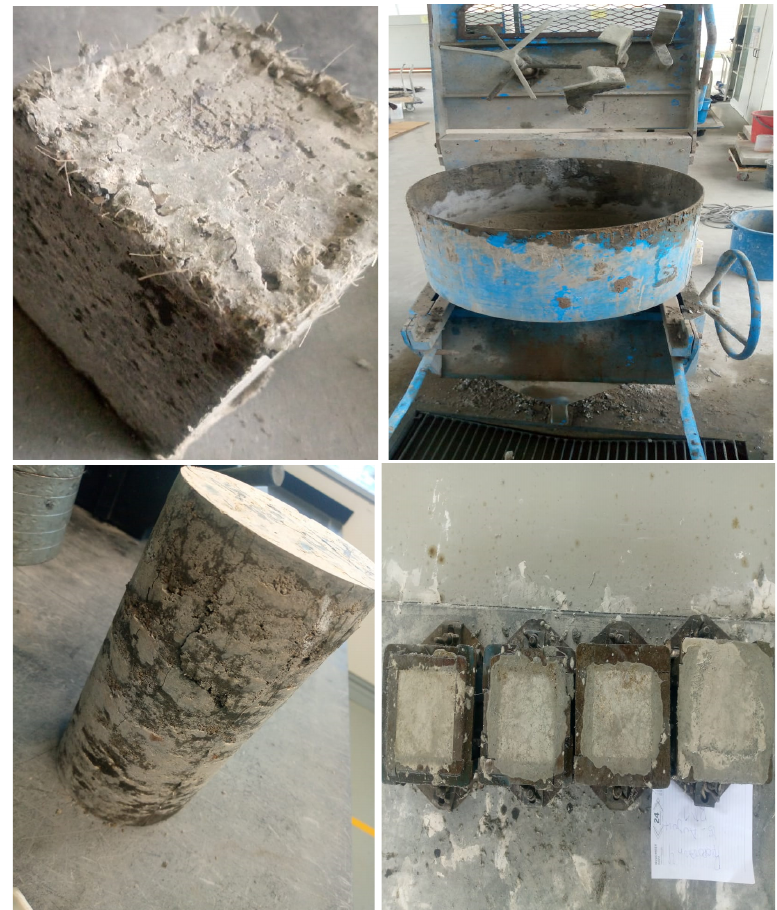
Figure 1. Sample preparation.